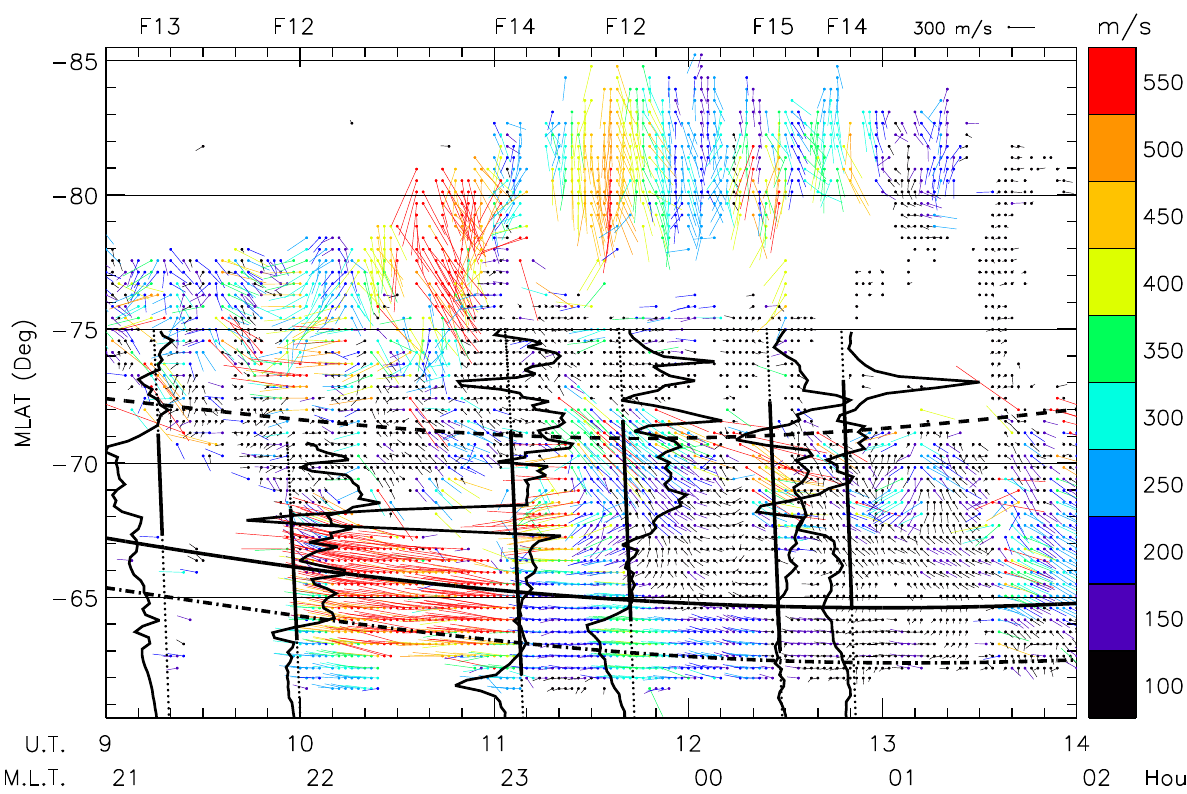
Fig. 4. Two-dimensional flow vectors estimated along TIGER beam 4 using the beam-swinging technique at 2-min time resolution during 09:00 to 14:00UT on 27 February 2000. The solid dots correspond to the time and latitude of the velocity estimate, and the flows were in the direction of the lines leaving the dots. Flows directed toward the right were eastward, and toward the bottom, equatorward. The flow speeds were colour-coded from < 125ms − 1 (black) to > 525ms − 1 (red), and the linear scale for an eastward flow of 300ms − 1 is shown at top right. As in Fig. 3, the six bold diagonal line segments represent the location of the auroral oval identified along nearby transits of the DMSP satellites. The fluctuating black curves represent the DMSP ion drift measurements made transverse to the satellite tracks (west to the left). As in Fig. 1, Starkov’s (1994) model auroral oval boundaries have been